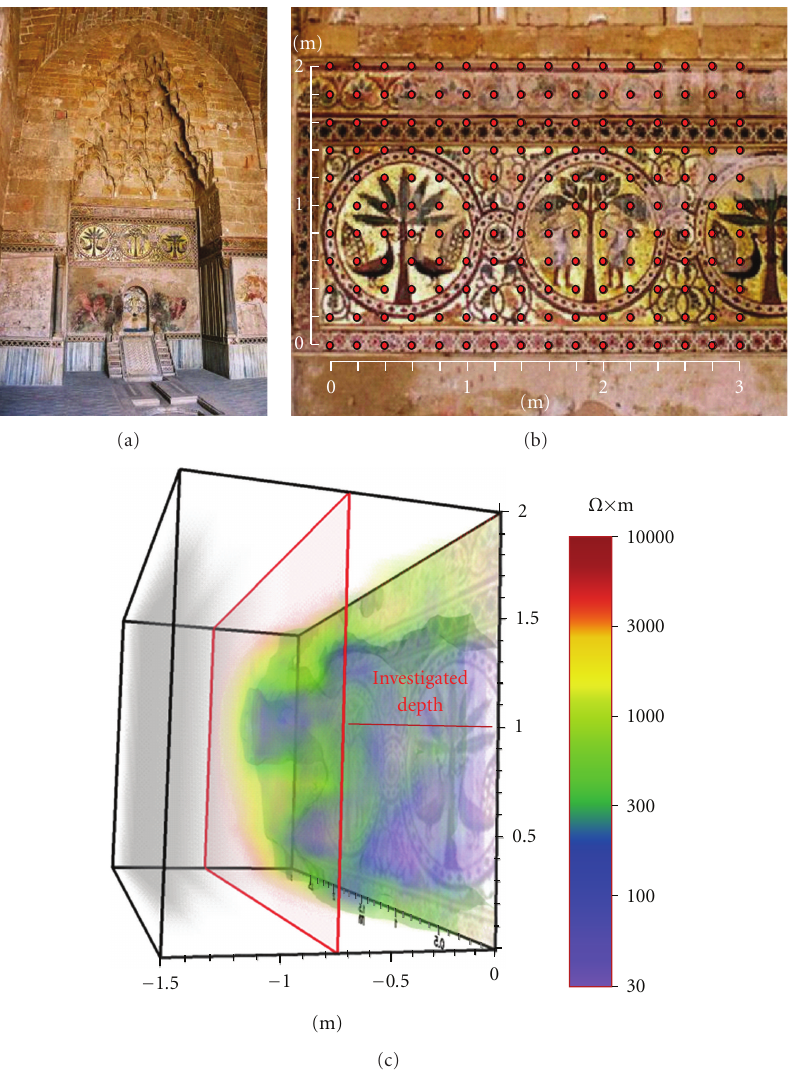
Figure 4: (a) Frontal wall of the Fountain Room of the Arabian Zisa Palace in Palermo; (b) part of the investigated mosaic wall where the grid of 176 potential electrodes was applied (red points). The 15 nails used to inject the current were inserted in as many selected points along the small, mortar-filled spaces between the tesserae of the mosaic; (c) 3D inversion model of the acquired data observed from the back of the wall (1.5m thick). Due to the size of the grid used (2m × 3m), the inversion model is limited to 0.75 m of depth. All dimensions are in meters (after [4],